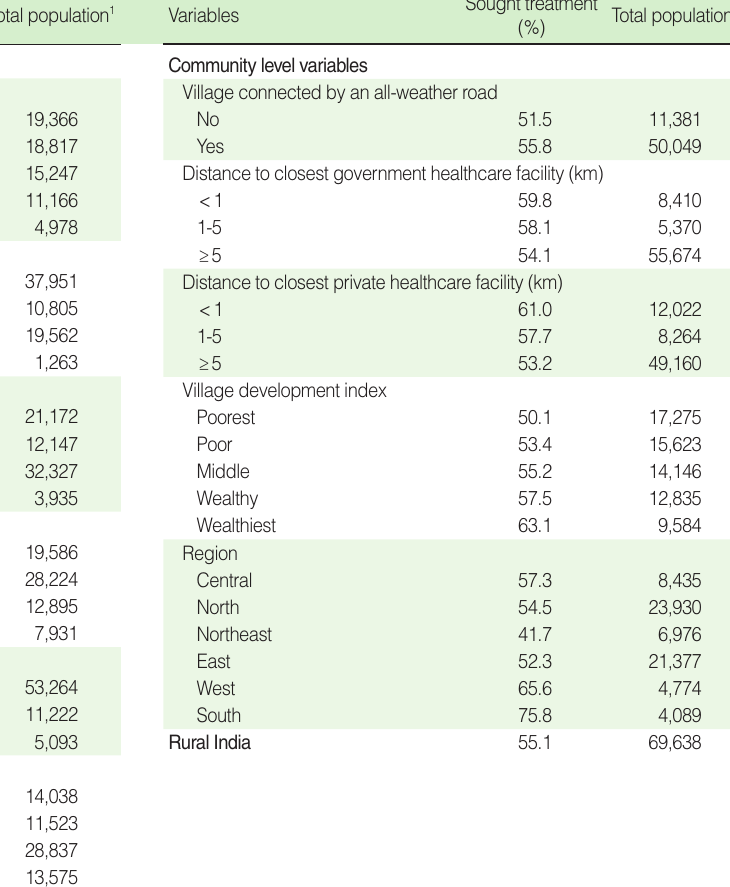
Table 2. Proportion of currently married women (aged 15-49 years) residing in rural India during 2007-2008 who sought advice or treatment after experiencing one or more postpartum morbidity within six weeks after delivery Sought treatment Variables Total population (%)